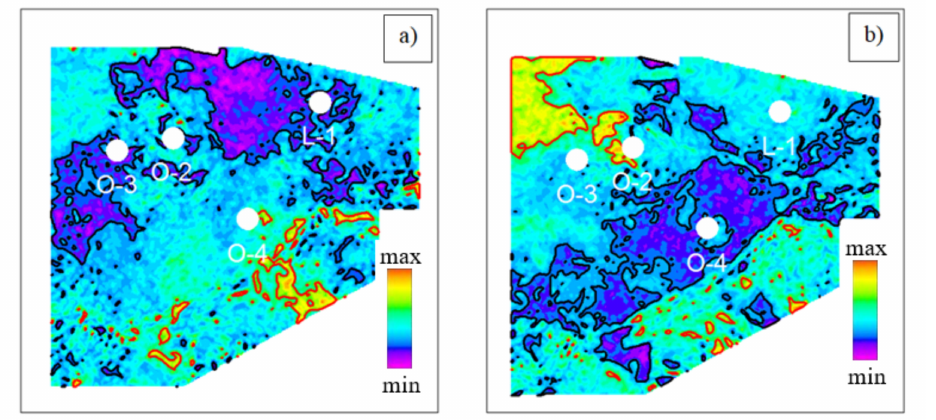
Figure 6. Map of average values of normalized BI of both variants within ( a ) Source I and ( b ) Source II. Maximum ( > 0.7) and minimum ( < 0.2) values of BI are marked with red and black polygons, respectively.